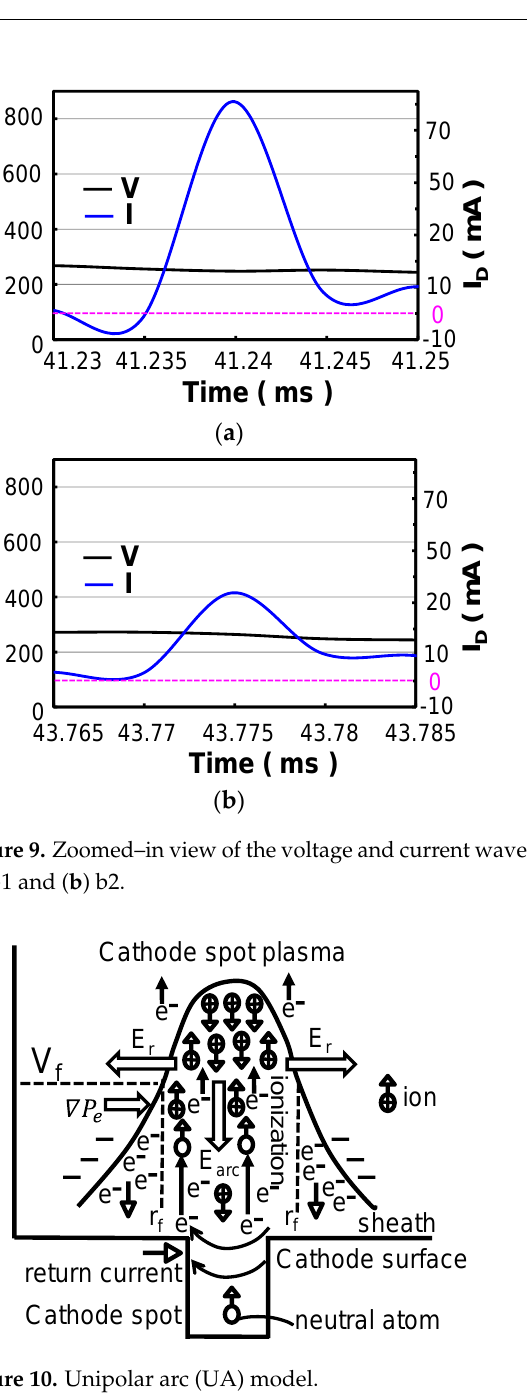
Figure 10. Unipolar arc (UA) model.